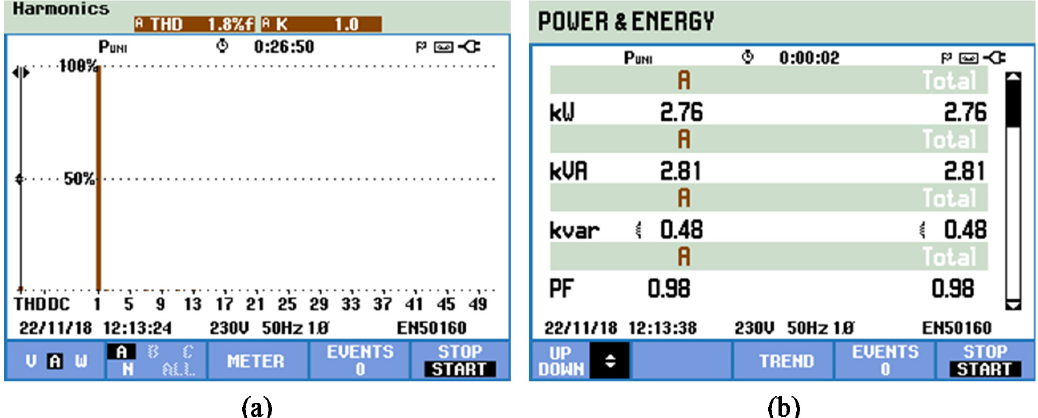
Figure 27. Experimental results during the MF-EVCS operation combined with the operation of an on-board EV charger (compensating current harmonics): ( a ) Harmonic spectrum of the total home current ( i g ); ( b ) Operating powers and total power factor.